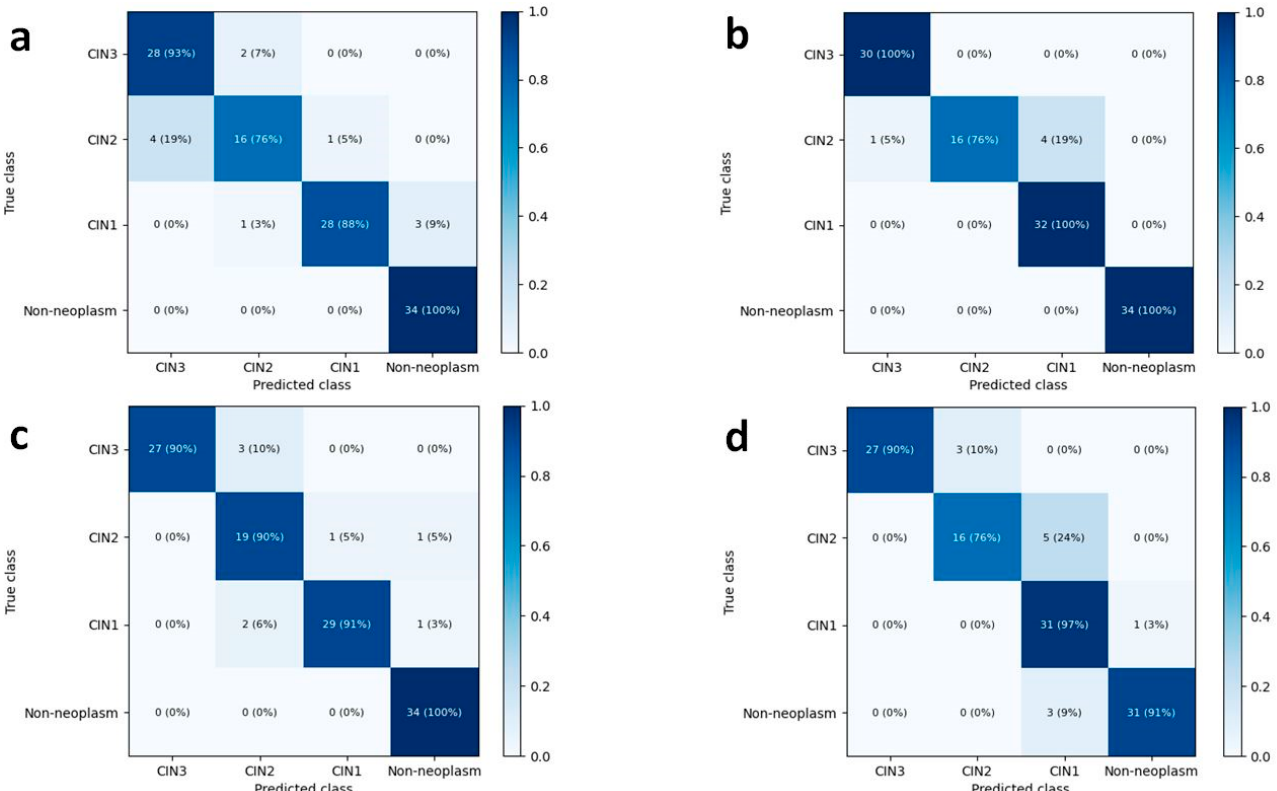
Figure 2. Heatmaps for confusion matrix of the best-performing CNN models and human pathologists in the four-class classification. There were three false-negative cases in the best-performing DenseNet-161 ( a ) model, there was no false-negative or false-positive case with the best-performing EfficientNet-B7 ( b ). Pathologist 1 ( c ) classified CIN2 with higher sensitivity than pathologist 2 ( d ).